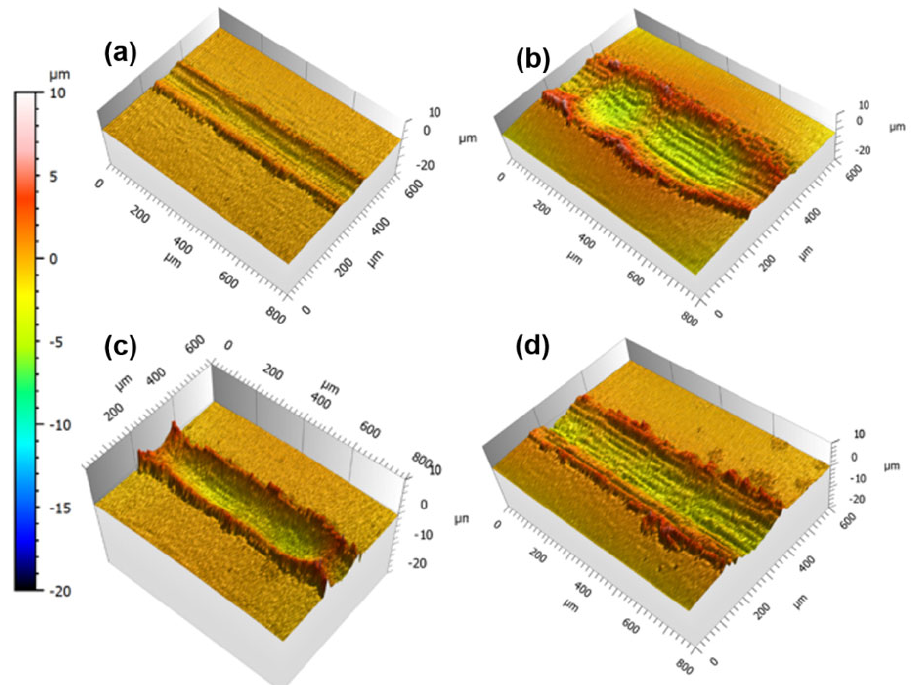
Fig. 10 3D profilometer images of wear tracks on the steel disks after lubricated with (a) MO at room temperature, (b) MO at 100 ºC, (c) 1 wt% DCi+MO at room temperature, and (d) 1 wt% DCi+MO at 100